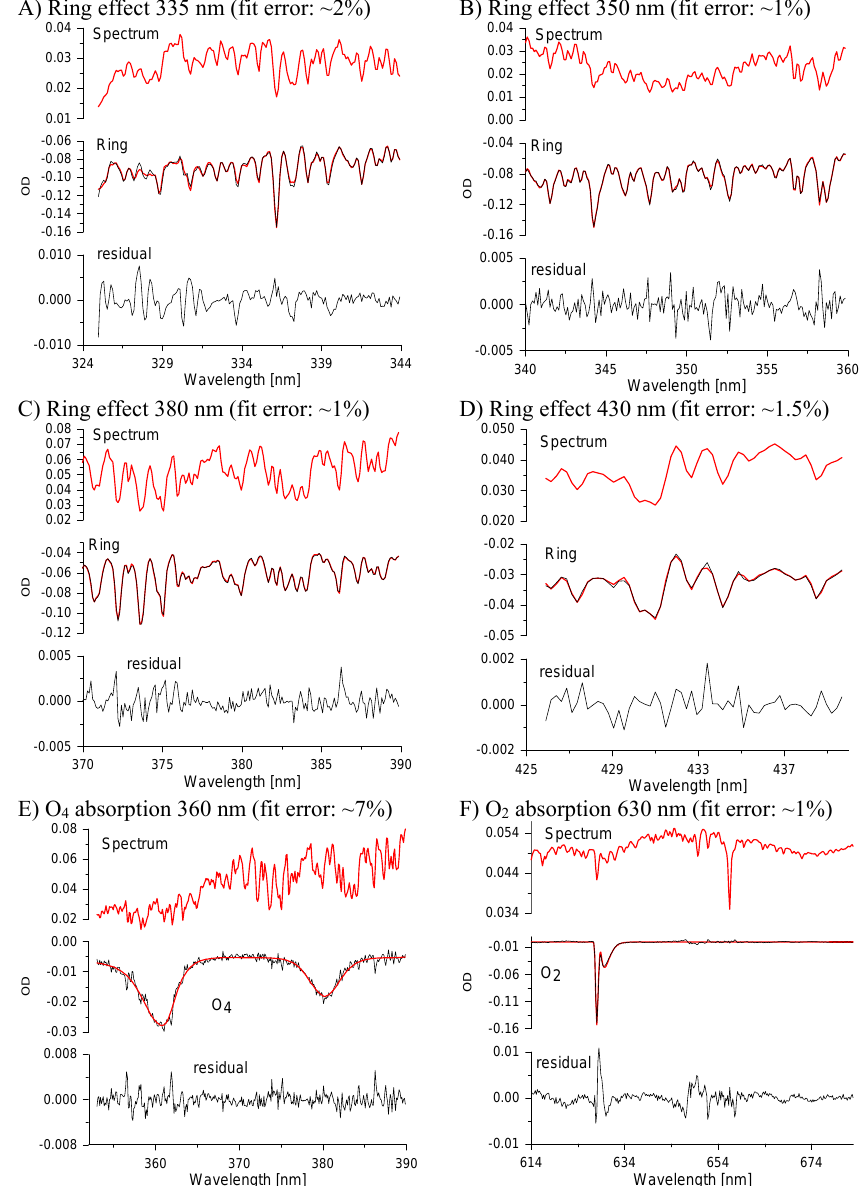
Fig. 3 Fit results of the spectral analyses of the Ring effect in different wavelength ranges (A to D) and the O 2 and O 4 absorptions (E, F). In each graph, the top panels show the measured raw spectra; the middle panels show the respective reference spectra (red) and the retrieved signature from the spectral analysis (black); the bottom panels show the spectral residuals.